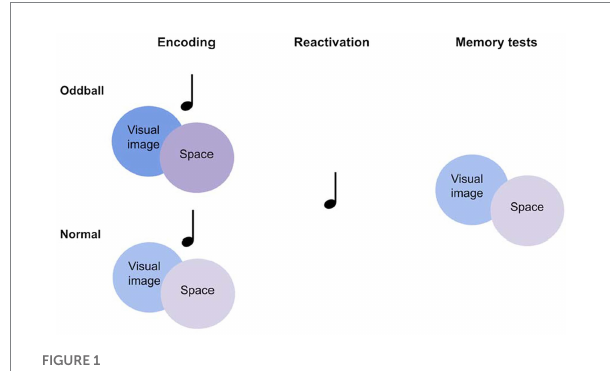
FIGURE 1 Graphic representation of the multisensory oddball memory